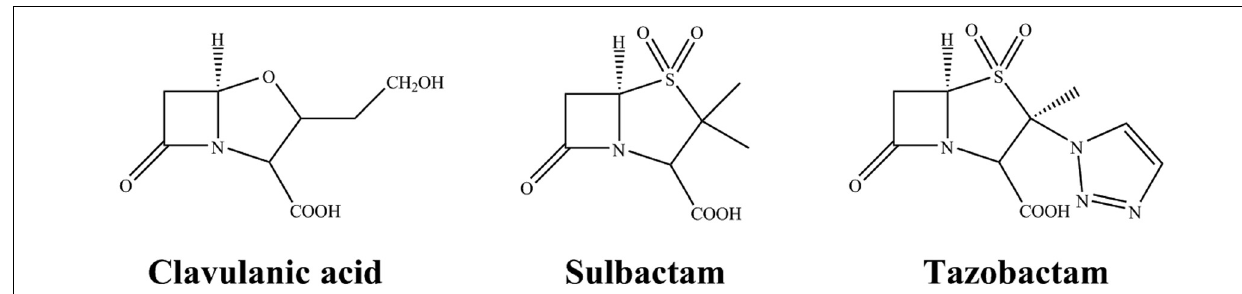
FIGURE 1 | Chemical structures of the clinically available β -lactamase inhibitors.